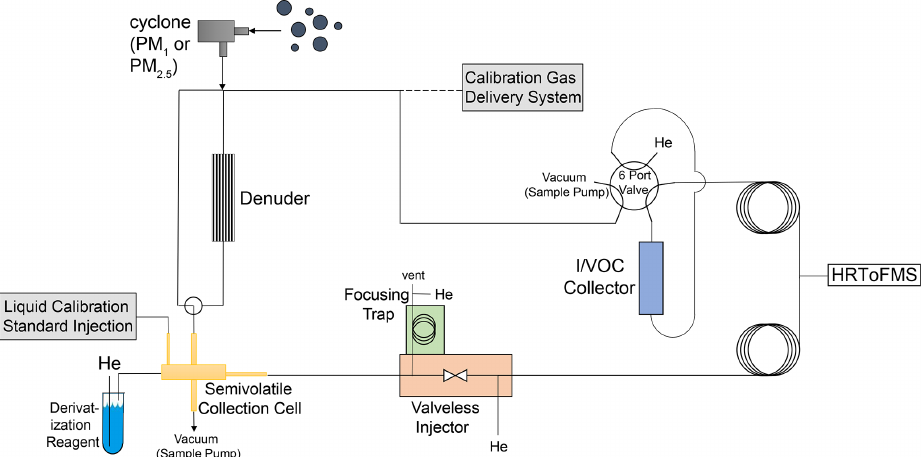
Figure 1. Schematic of cTAG. VOCs and IVOCs are collected on the I/VOC collector while SVOCs are collected on the collection and thermal desorption cell. The I/VOC and SVOC channels are independent until the GC column outputs from each channel meet and enter the HRToFMS. Optionally, the SVOC channel can collect only particle-phase SVOCs by first passing sampled air through a denuder that removes all gas-phase compounds. A derivatization agent introduced upon desorption of the SVOCs from the collection cell enables detection of polar SVOCs in addition to nonpolar ones. Sample collection happens in parallel, for 23min, followed by analysis of the I/VOC collector contents and then analysis of the semivolatile collection cell contents, for a total turnaround time of 1h. Calibration is done for VOCs and IVOCs by manually disconnecting the ambient inlet and connecting and sampling the output of the calibration gas delivery system (Fig. 3) and for SVOCs via liquid standard injections onto the semivolatile collection cell.